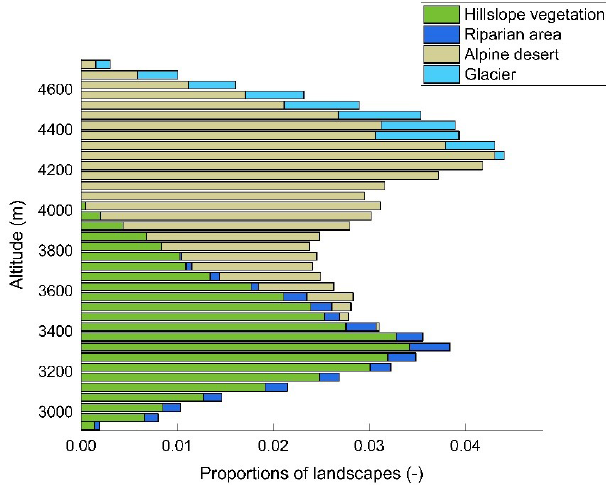
Figure 2. Landscape classification at different elevation bands (with 50m interval) of the Hulu